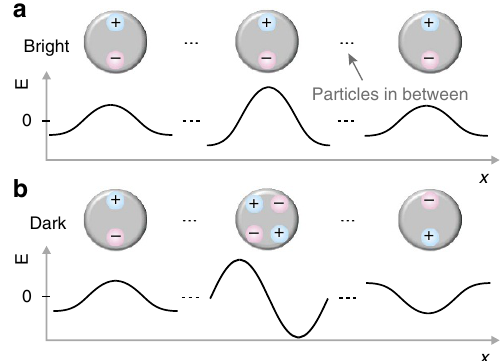
Figure 4 | Evolution of the radiation fields in the case of a finite array size. ( a ) For a bright mode, the phase across the array remains constant due to constructive interference of the counter-propagating radiation fields at each particle location. The amplitude at the edge, however, will be reduced to one half as there are no particles and therefore no radiation incident from the other side. ( b ) For a dark mode, particles in the array are driven by left- and right-propagating radiation fields, which destructively interfere at the particle locations and therefore create a standing wave node and a quadrupole excitation. As one moves away from the centre; however, the destructive interference becomes gradually less complete due to unequal number of particles contributing to left- and right-propagating waves. This results in a buildup of dipole moments whose relative weight compared to the quadrupoles gradually increases when moving away from the centre of the array. Importantly, for the dark mode the dipoles induced by the left- and right-propagating radiation fields are out of phase by p . The dark mode in a finite lattice is thus different from the one in an infinite lattice: it features dipole moments and can thus be viewed as a hybrid mode with characteristics of both the bright and dark modes of an infinite lattice.